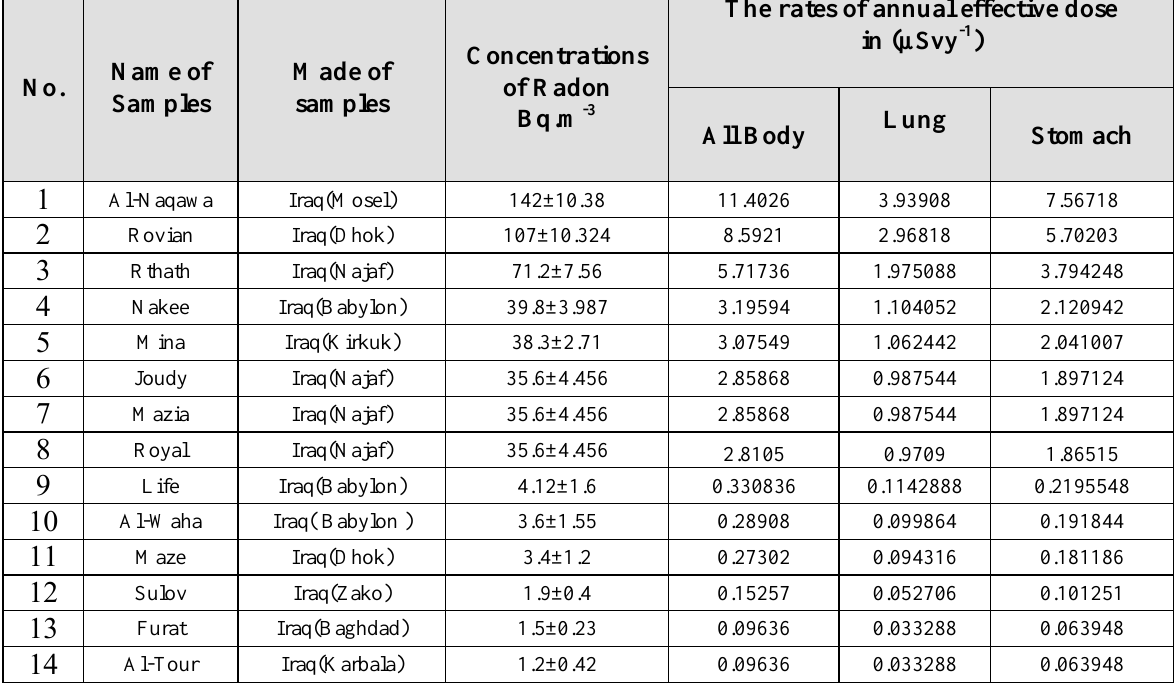
Table 1: The concentration of ( 222 Rn) in (Bq.m -3 ) and the rate annual effective dose of 222 Rn in µSv.y -1 in healthy drinking water samples